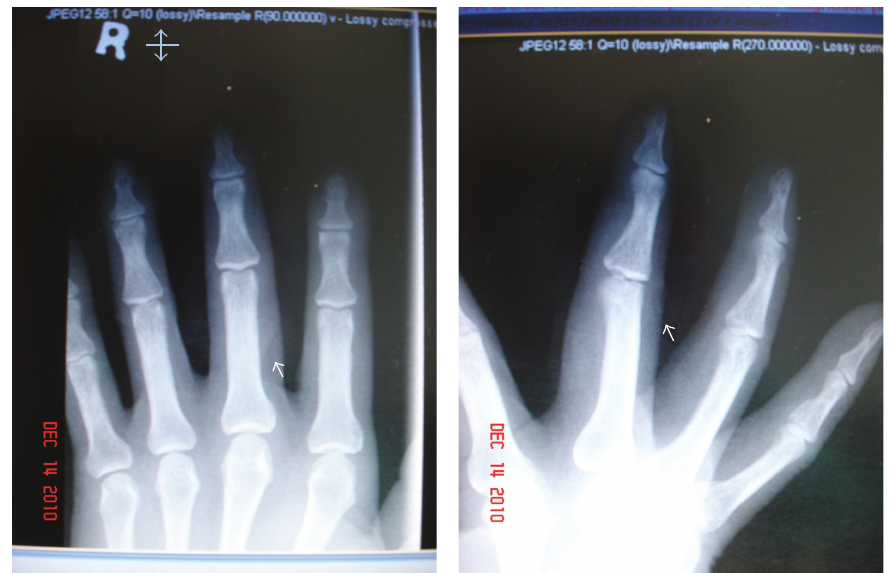
Figure 1: Anteroposterior and lateral views of plain radiographs of the hand. There is no evidence of bony irregularity.